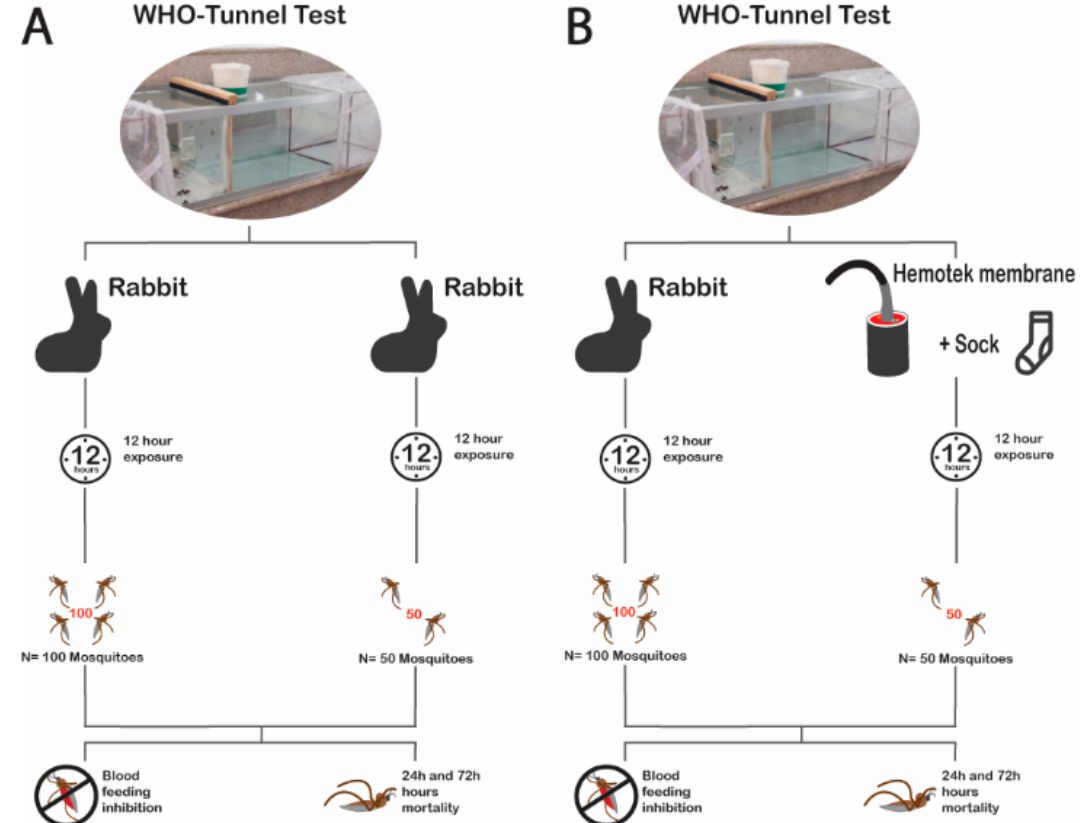
Figure 3. Flow chart of experimental procedure: Experiment 3 ( A —effects of mosquito density 100 vs . 50) and Experiment 4 ( B —possibility to replace 100-rabbit bioassay with 50-Hemotek